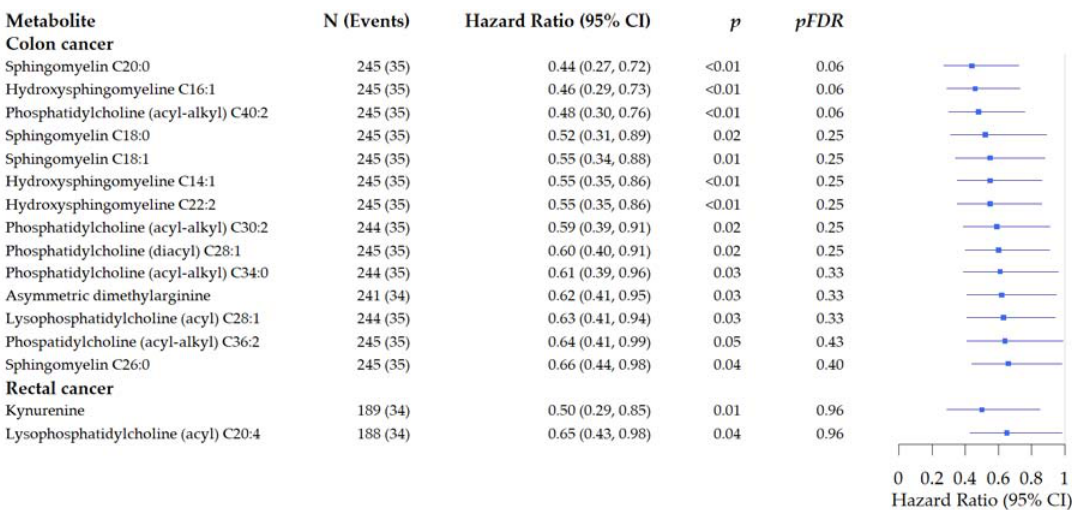
Figure 4. Forest plots of the associations of pre-surgery metabolite concentrations with risk of recurrence in prospectively followed colorectal cancer patients stratified by tumor site. Analysis are adjusted for age, sex, tumor stage, BMI (kg/m 2 ), and study cohort. (Hazard ratio and 95% Confidence Interval).